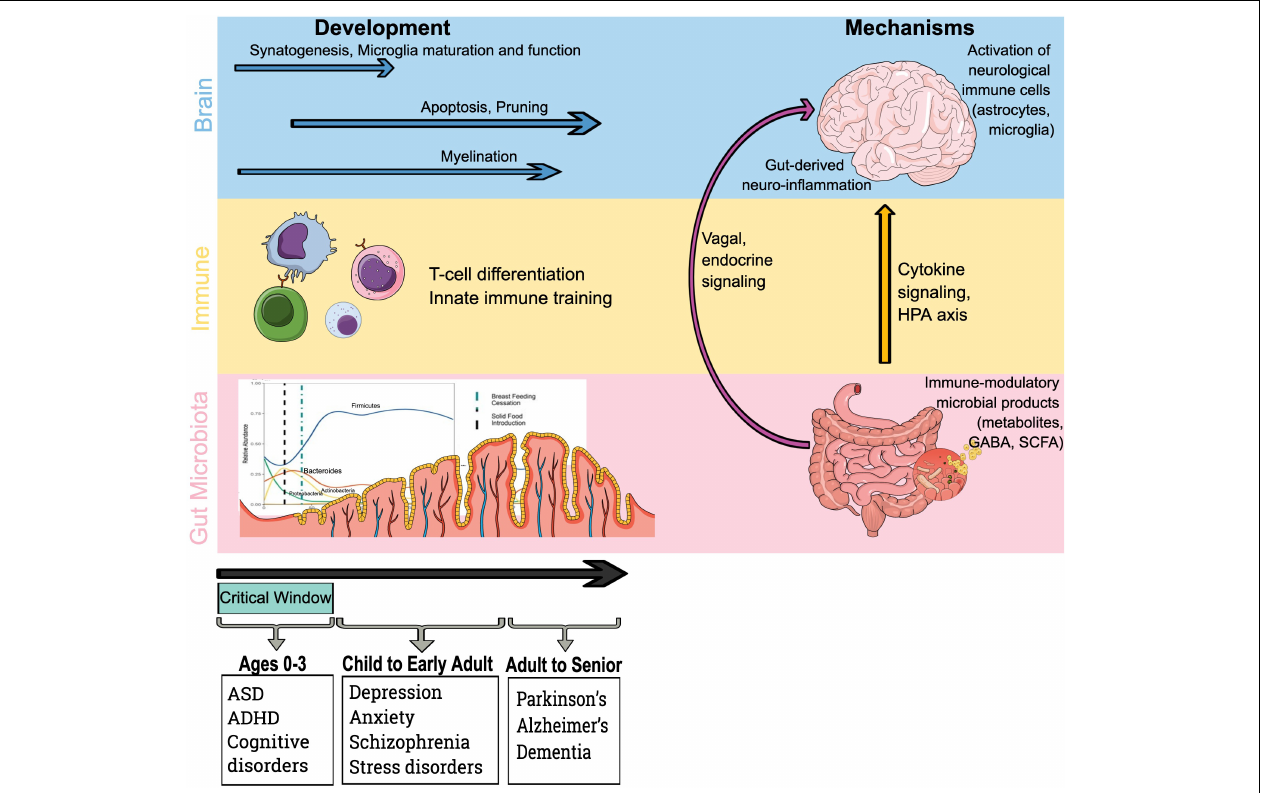
FIGURE 1 | Microbiota, immune and brain development drive mechanistic pathways by which the gut microbiota influences the brain. Existing evidence indicates that early life represents a critical phase in brain development and immune training via microbial colonization and early life exposures. Furthermore, immune-mediated mechanisms by which bacteria access the brain and influence neurological outcomes include the impact of immune-modulatory bacterial products on brain. HPA axis, hypothalamic–pituitary–adrenal axis; GABA, γ -aminobutyric acid; and SCFA, short-chain fatty